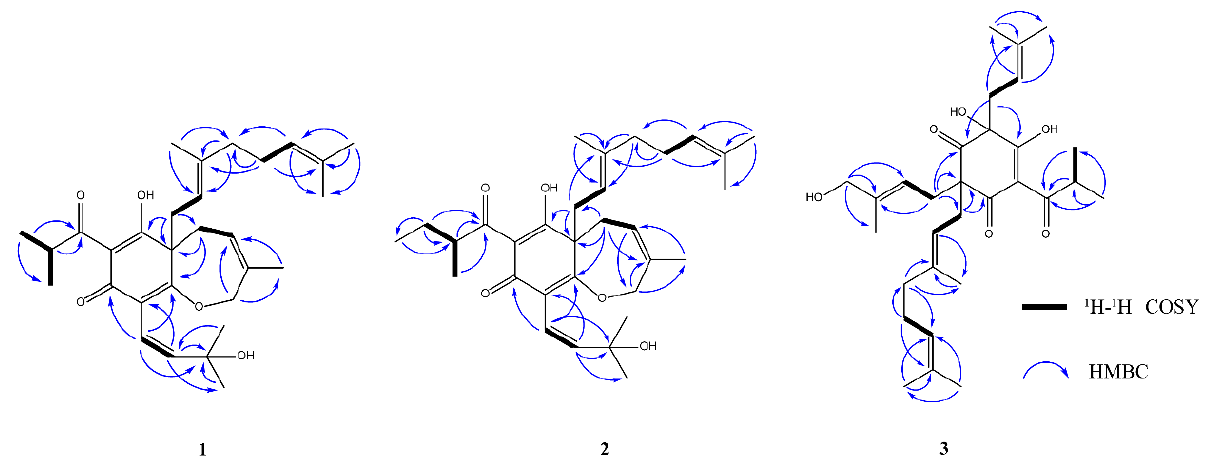
Figure 6. The key 1 H- 1 H COSY and HMBC correlations of 1 - 3 . Compound 2 was obtained as a yellow oil. High-resolution electrospray ionization mass spectra (HR-ESI-MS) showed a pseudo-molecular ion peak at m/z 497.3270 [M+H] + (calculated C 31 H 45 O 5 , m/z 497.3267 [M+H] + ), corresponding to the molecular formula C 31 H 44 O 5 and 10 degrees of unsaturation. Analysis of 1 H NMR, 13 C NMR and DEPT data (Table 3) showed that 2 had 11 quaternary carbons and 20 protonated (eight methyl, six methylenes, and six methines) carbon atoms. Compound 2 contained a group of typical signals of phloroglucinol [ δ C 187.0 (C-1), δ C 106.8 (C-2), δ C 171.4 (C-3), δ C 57.8 (C-4), δ C 196.4 (C-5), δ C 107.3 (C-6)]. However, in comparison to 1 , the molecular formula of 2 was found to contain 14 more mass units, suggesting the presence of an extra methylene. The available NMR data of 1 were compared with those derived from the 1 H NMR, 13 C NMR and HMBC spectra of 2 ; it was found that both compounds 1 and 2 had the same parent nucleus. As expected, compound 2 also had a seven-membered ring connected to the six-membered ring, and one geranyl group along with a oxygenated prenyl unit was determined. 1 H-NMR data showed that δ H 1.35 (H-30) of 2 was different from 1 at δ H 1.12 (H-30), and in the 1 H- 1 H COSY spectrum of 2 , H-30 ( δ H 1.35) and H-28 ( δ H 3.81) had a relevant signal. In the HMBC spectrum, H-30 ( δ H 1.35) was correlated with C-28 ( δ C 42.1), C-29 ( δ C 16.4), C-27 ( δ C 207.6), and C-31 ( δ C 12.0), and H-31 ( δ H 0.89) was related to C-28 ( δ C 42.1) and C-30 ( δ C 26.9), indicating that C-30 was connected to a methyl group. Its key 1 H- 1 H COSY and HMBC correlations are shown in Figure 6. In conclusion, the structure of 2 was determined and identified as a new polycyclic isopentenyl phloroglucinol and named garxanthochin B.